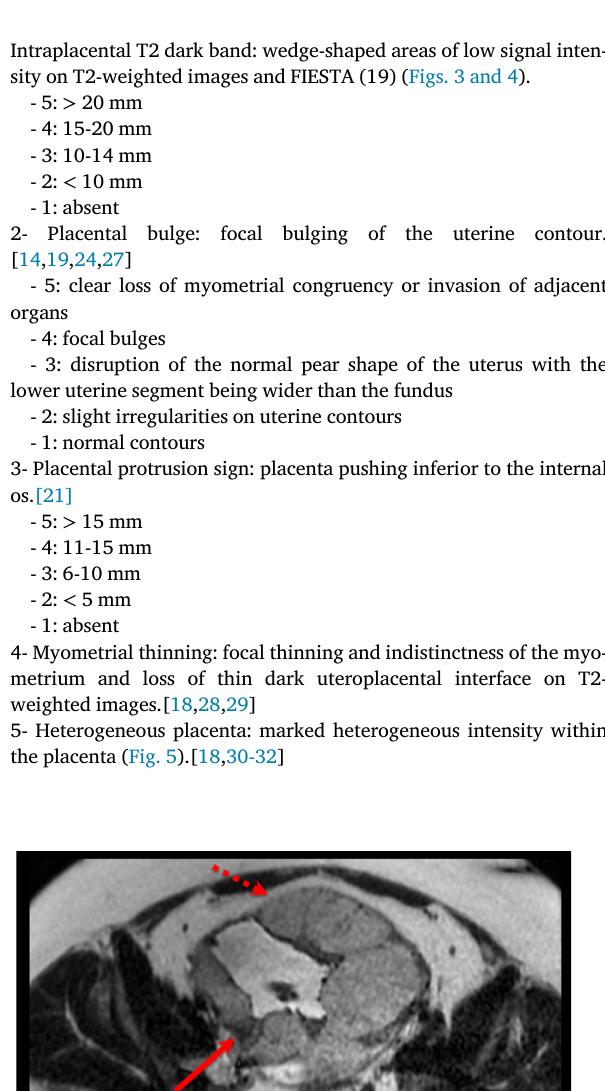
Fig. 3. 34-year-old woman at 36 weeks ' gestation and one previous C-section. (A) Sagittal T2 weighted image shows intraplacental T2 dark band (arrow), and on (B) sagittal FIESTA the band remains with the low signal intensity.